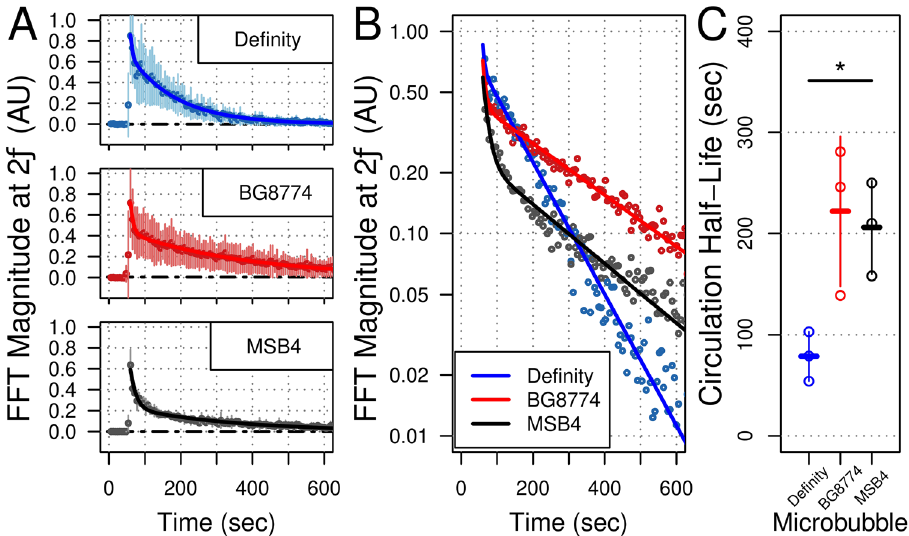
Figure 3. Half-life in circulation. ( A ) Decay in the magnitude of 2 f emissions were used to estimate the concentration of each microbubble formulation as a function of time (n = 3 animals/microbubble formulation). The mean decay for each microbubble formulation is depicted. Each microbubble formulation displayed a biphasic decay; half-life in circulation was estimated during the terminal phase. ( B ) Decay in the magnitude of 2 f emissions plotted on a semi-log scale highlight the differences in decay characteristics for each microbubble formulation. ( C ) Definity displayed a mean half-life of 79 s ± 25 s, significantly less than MSB4 at 206 s ± 46 s (p = 0.04). BG8774 displayed a mean half-life of 222 s ± 73 s, trending towards significantly greater than Definity (p = 0.06). AU arbitrary units, FFT fast Fourier